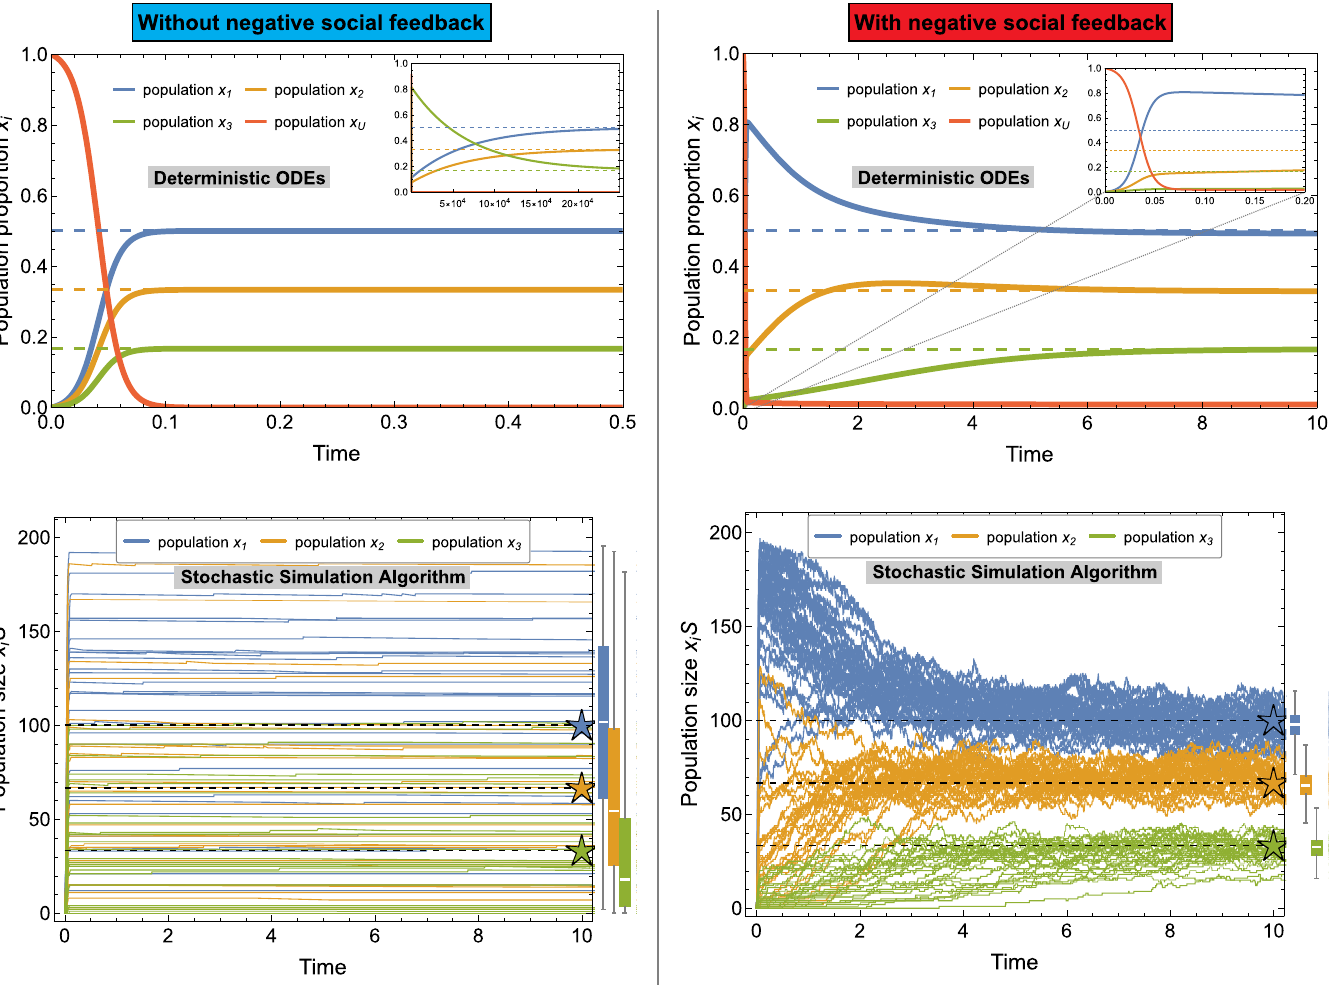
Fig 1. Temporal evolution of the models without (left) and with (right) negative social feedback in an environment with n = 3 food patches with qualities q 1 = 0.75, q 2 = 0.5, q 3 = 0.25. The top panels show the dynamics of the ODEs for systems of infinite size S ! 1 . The bottom panels show the trajectories of 30 representative runs of the stochastic simulation algorithm (SSA, [25]) for a system comprised of S = 200 individuals. The boxplots on the right of each bottom panel show the statistical aggregate at time 400 for 1000 runs of the SSA. (Other simulation parameters are: constant abandonment a = 10 − 3 , average recruitment strength r = 100, and stop signal strength z ’ 3.1.) While the infinite size dynamics predict convergence to the target distribution of Eq (1) (dashed lines) for both models, the stochastic trajectories show different results for the two models. The system without negative social feedback has smaller fluctuations over time but frequently stabilises at values far from the target distribution (bottom-left panel). The system with negative social feedback fluctuates more but always remains relatively close to the target distribution (bottom-right panel). The apparently quicker dynamics of the ODE model for the system without negative social feedback are due to the symmetric initial conditions. In the left inset, we show that a small perturbation of the initial population ( i.e. x 1 , x 2 = 0 and x 3 = 0.05) delays the convergence by more than 5 orders of magnitude. Such a susceptibility to random fluctuations is made evident by the stochastic trajectories. The right inset shows a zoom of the larger plot.